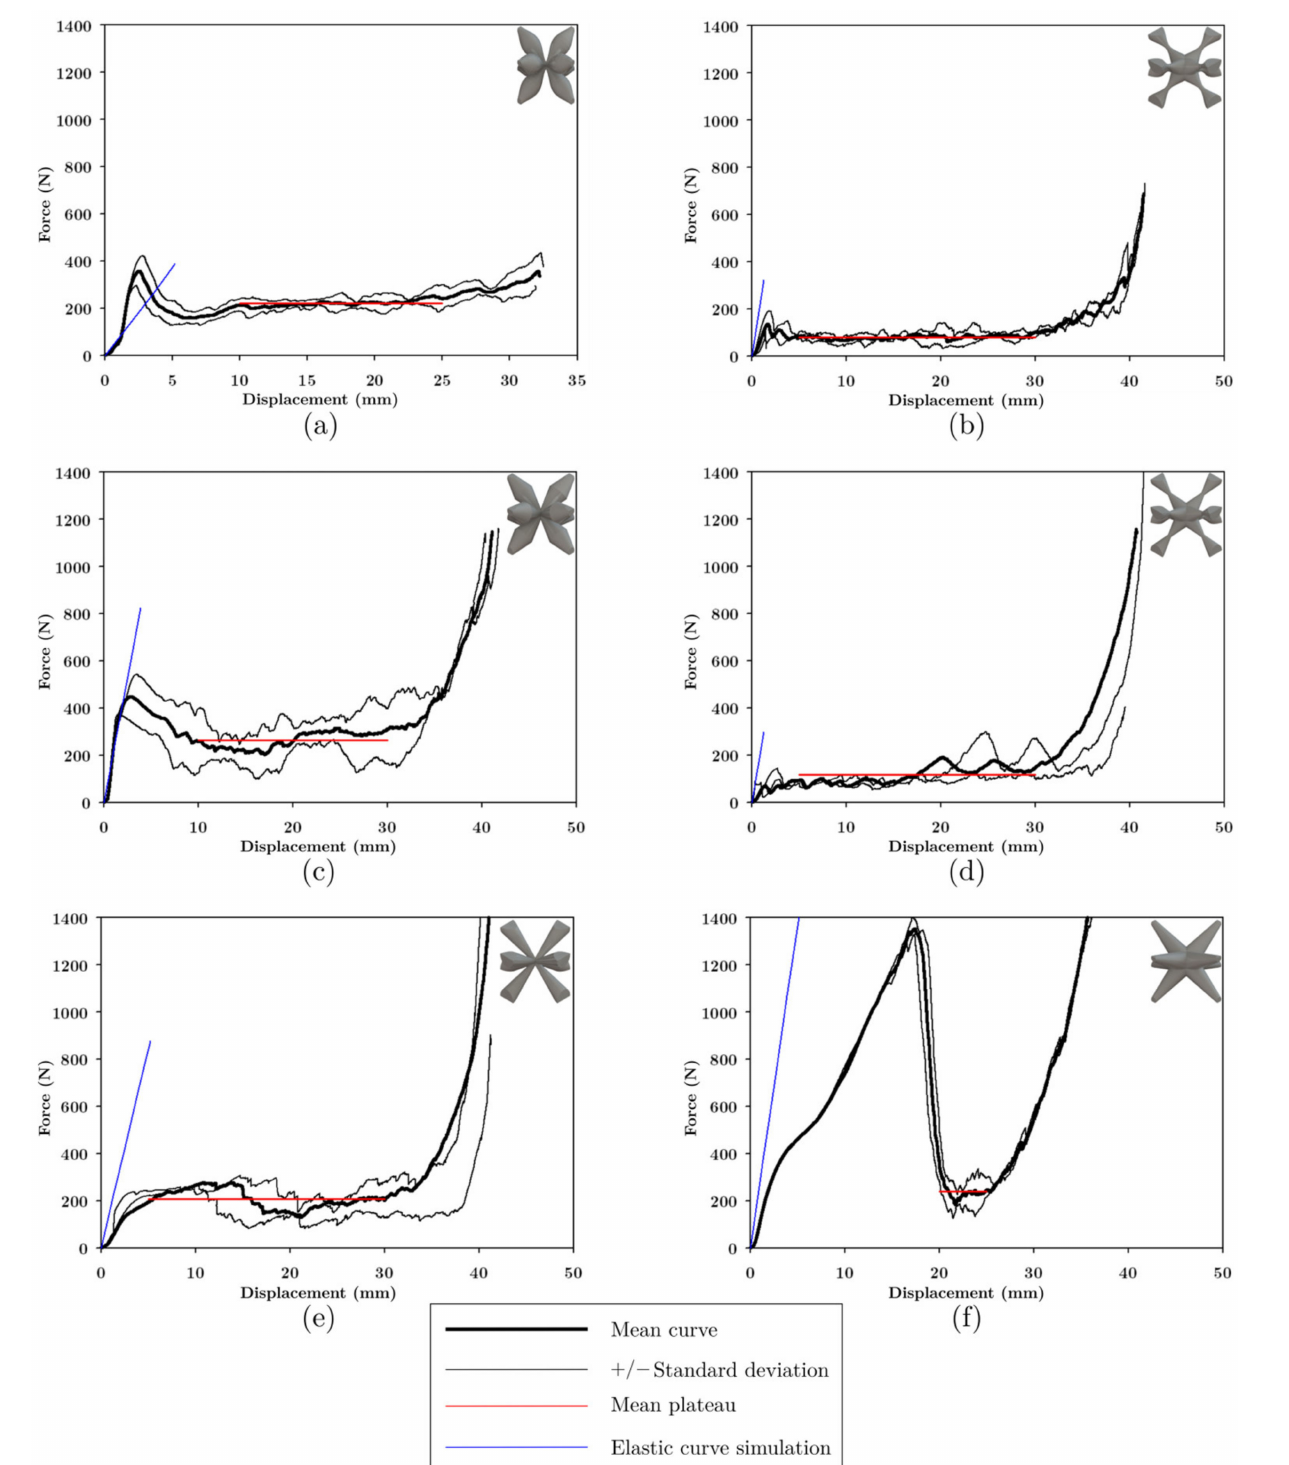
Figure 16. Force-Displacement curve of UPLS manufactured with PLA. For each variation in strut cross-section: ( a ) COS, ( b ) COS2, ( c ) DS, ( d ) DIS, ( e ) PS, and ( f )